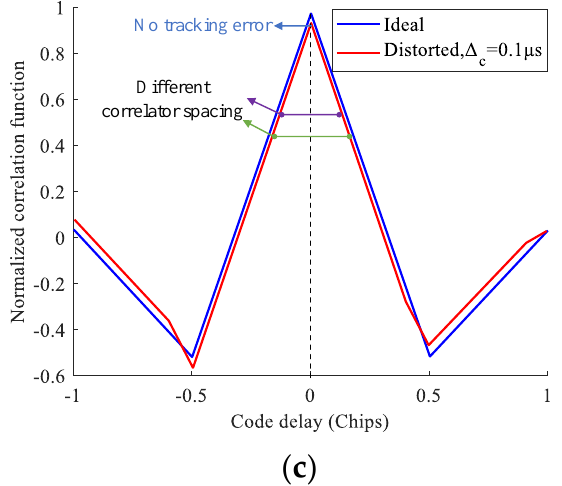
Figure 1. Correlation function of BOC (1,1) under three distortion types. ( a ) Analog distortion; ( b ) Subcarrier distortion; ( c ) PN code distortion.